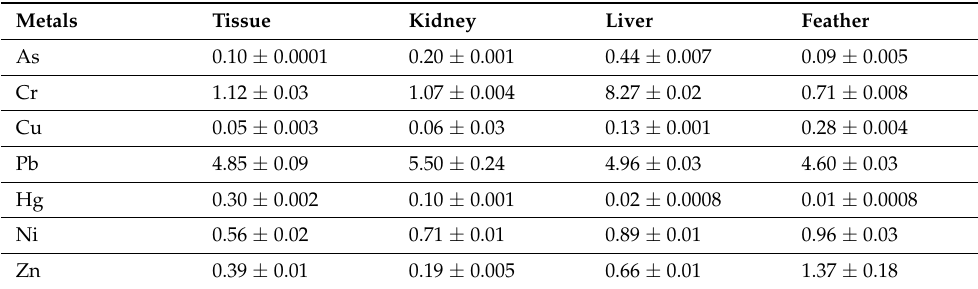
Table 1. Level of metals in the different organs of the Indian pond heron, Veeranam Lake, Cuddalore, District, Tamil Nadu. [Values are mean and SE; ppm (N = 3)].